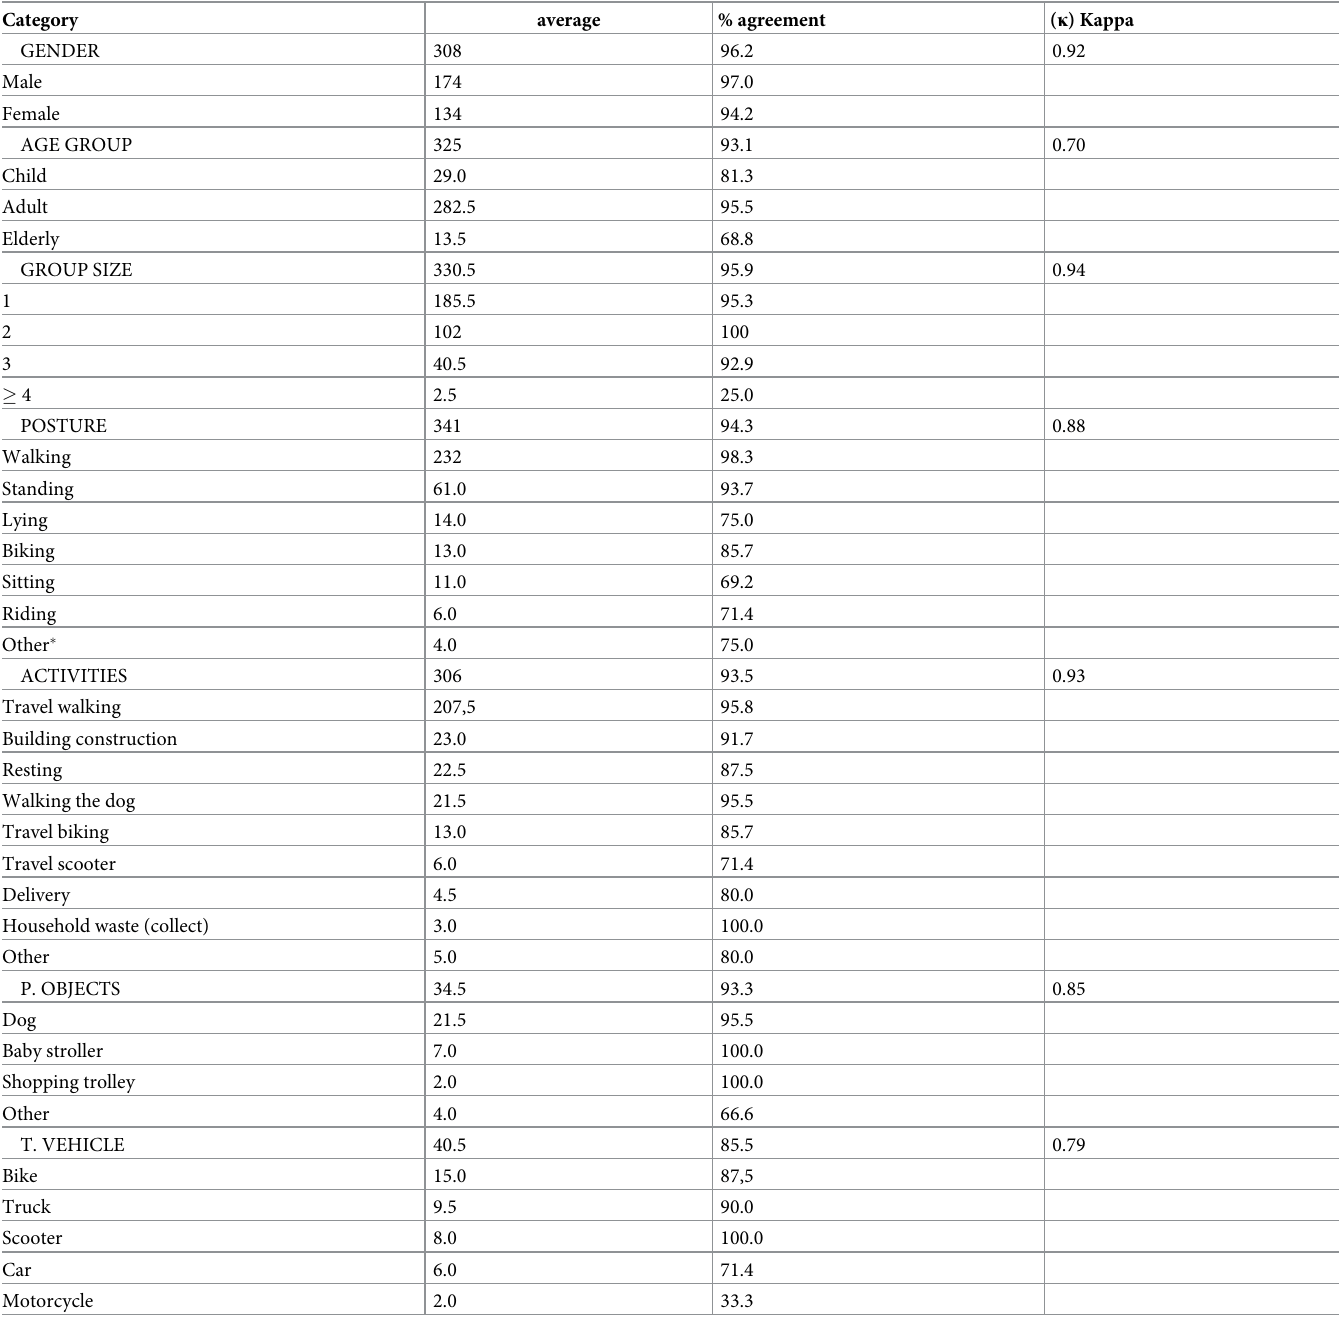
Table 1. Results for Cohen’s Kappa agreement between two raters watching UAV video in HDA.